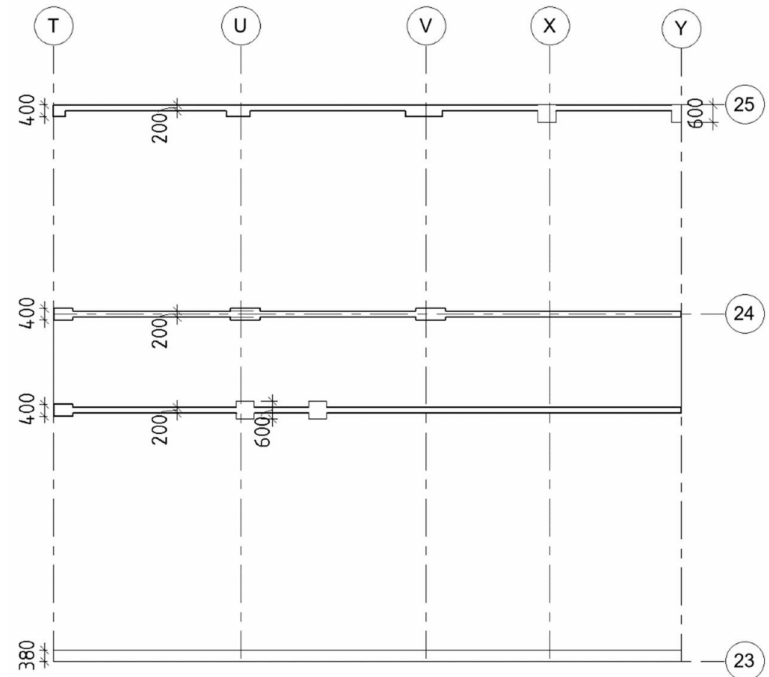
Figure 2. Basement plan (unit: